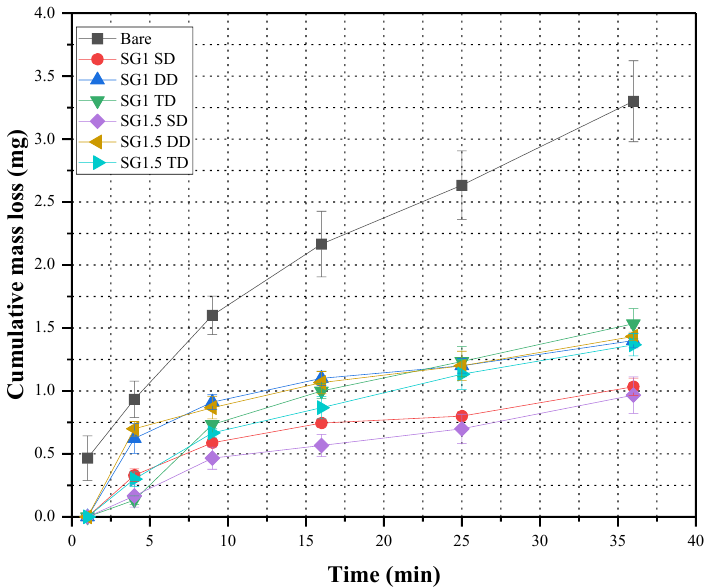
Figure 4. Graphical illustration of cumulative mass loss during cavitation test for uncoated, single, double and triple coated samples.